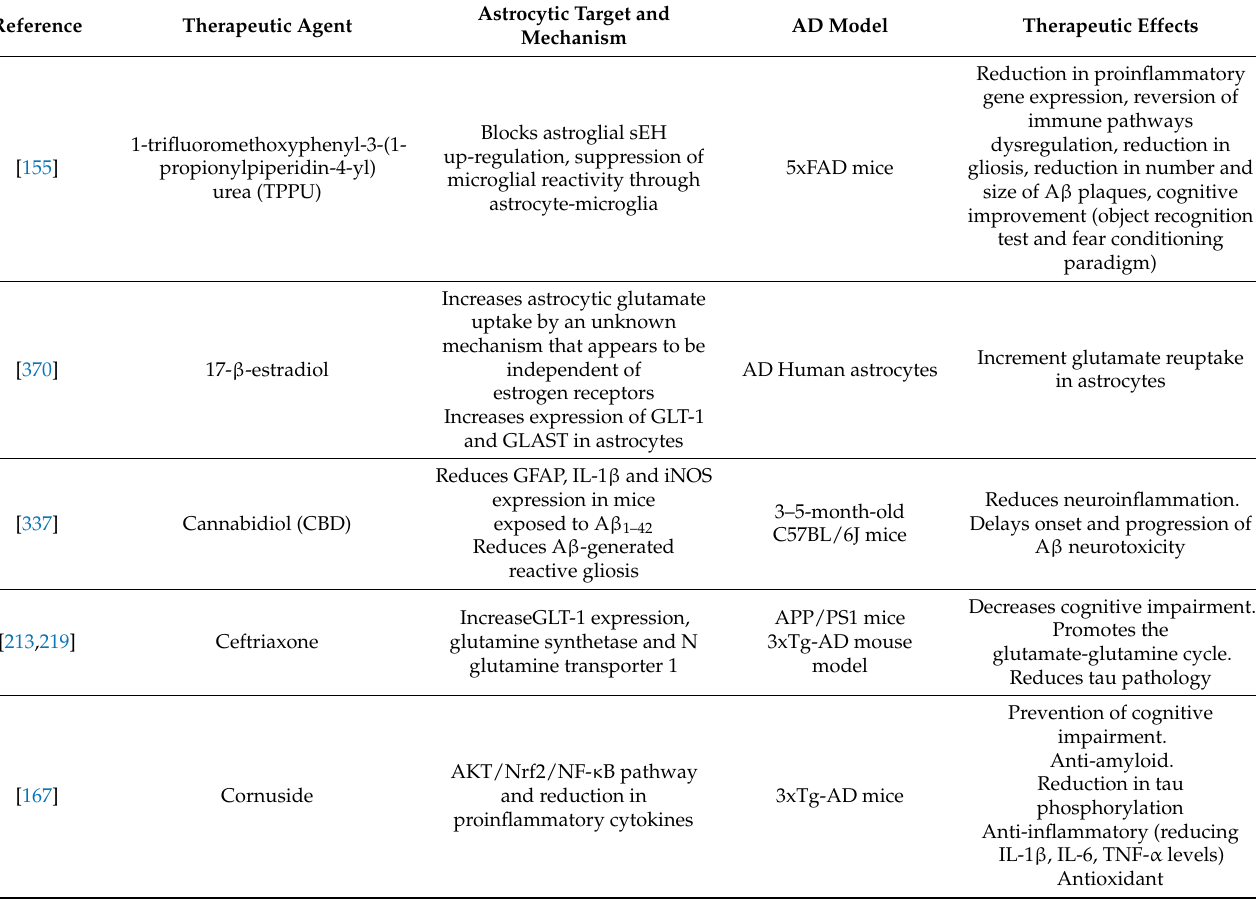
Table 1. Astrocytic therapeutic targets and molecules used in preclinical studies of AD. In the present table only molecules and drugs (in alphabetic order) that were probed in AD models (i.e., amyloidosis, tauopathy or transgenic animals) and also, that modulate directly or indirectly the astrocyte activity, were